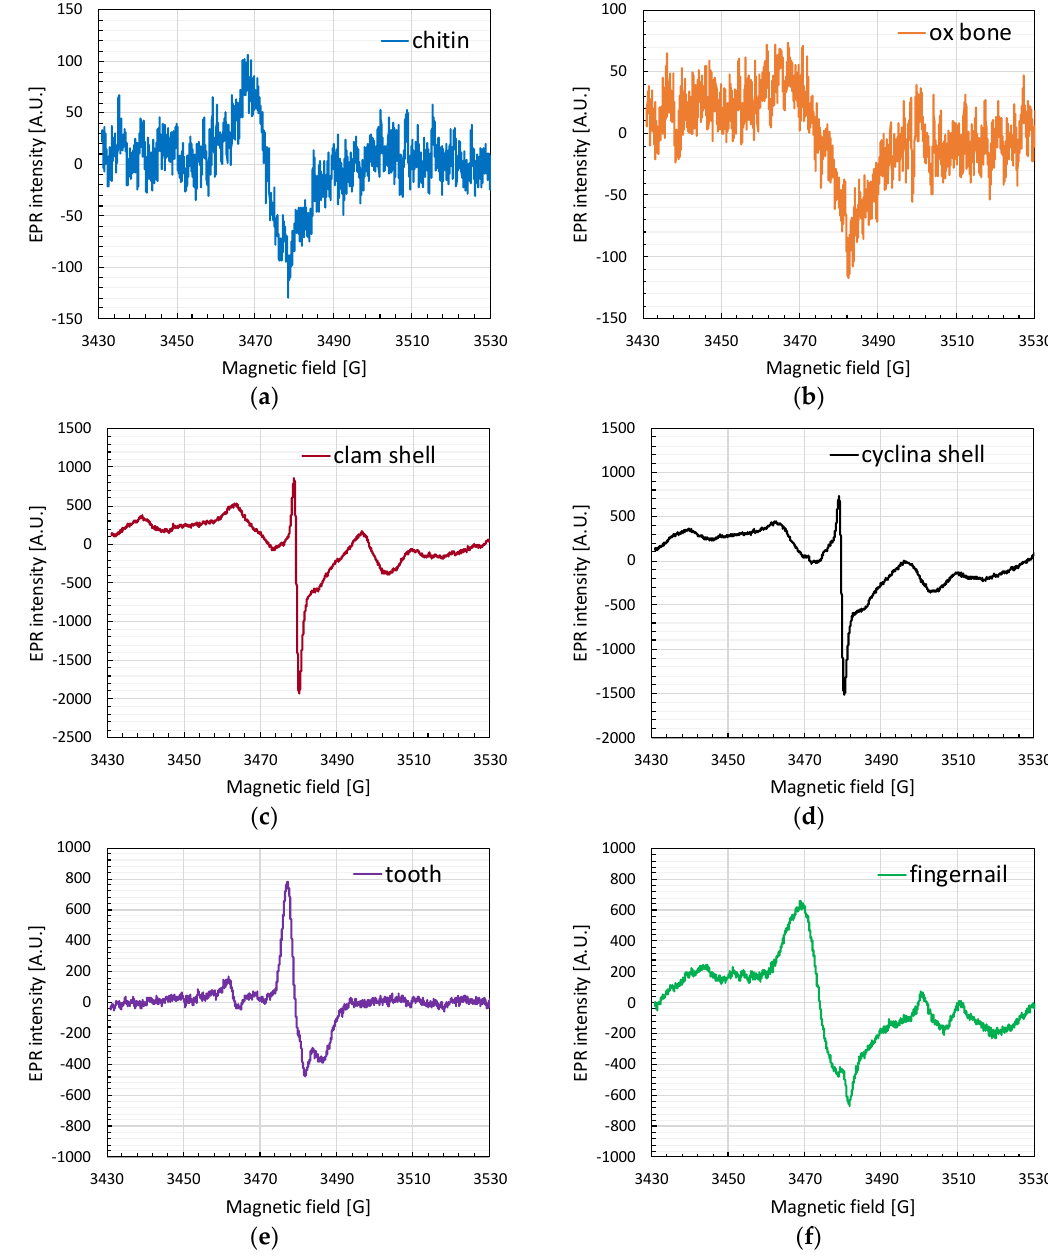
Figure 2. Typical EPR spectra of ( a ) chitin, ( b ) ox bone, ( c ) clam shell, ( d ) cyclina shell, ( e ) tooth and ( f ) fingernail exposed to 5 Gy photon irradiation.